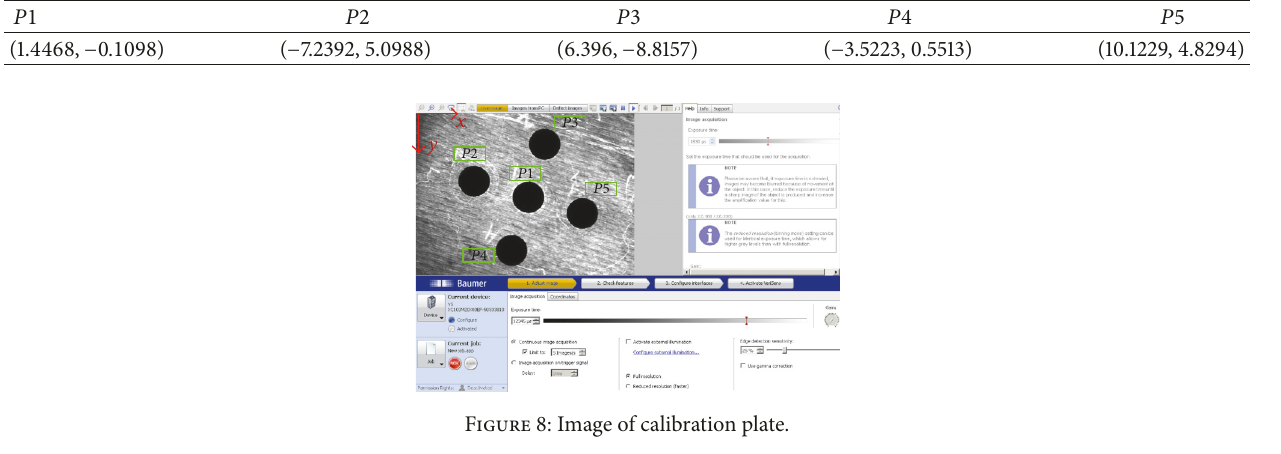
Figure 8: Image of calibration plate.